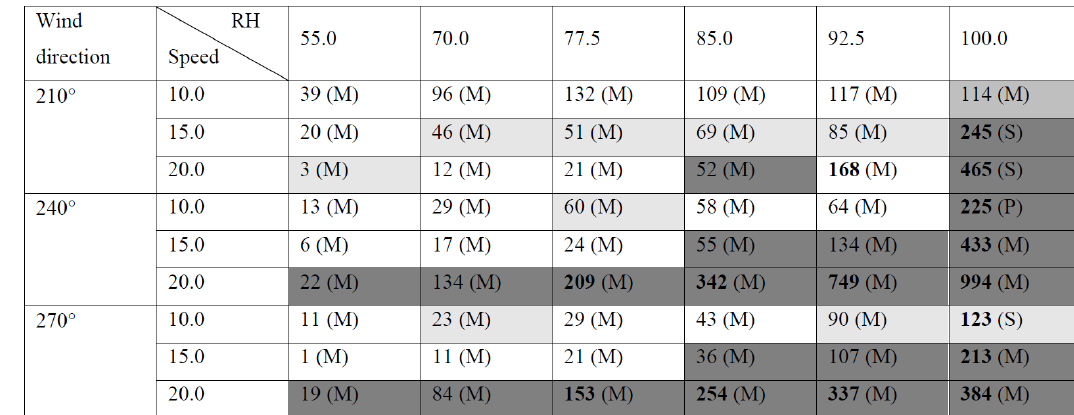
Table 6. As in Table 4 but for the daily peak rainfall over Taiwan (mm) in all the experiment set to test the effects of near-surface moisture. The results for different wind speed (ms − 1 ) and RH (%) from top to bottom are those with a wind direction from 210, 240, and 270 ◦ . The background colors of cells and boldface have the same meaning as for the subregions in Table 4, and the parenthesis gives the elevation range (P: plain; S: slope; or M: